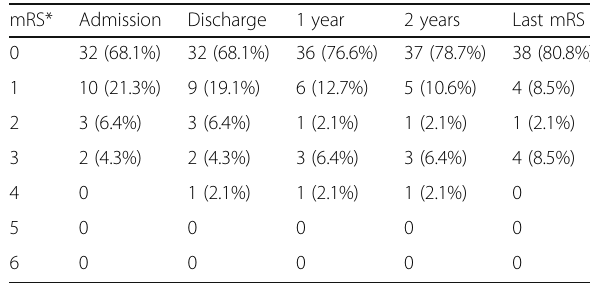
Table 2 modified Ranking Score (mRS) over time